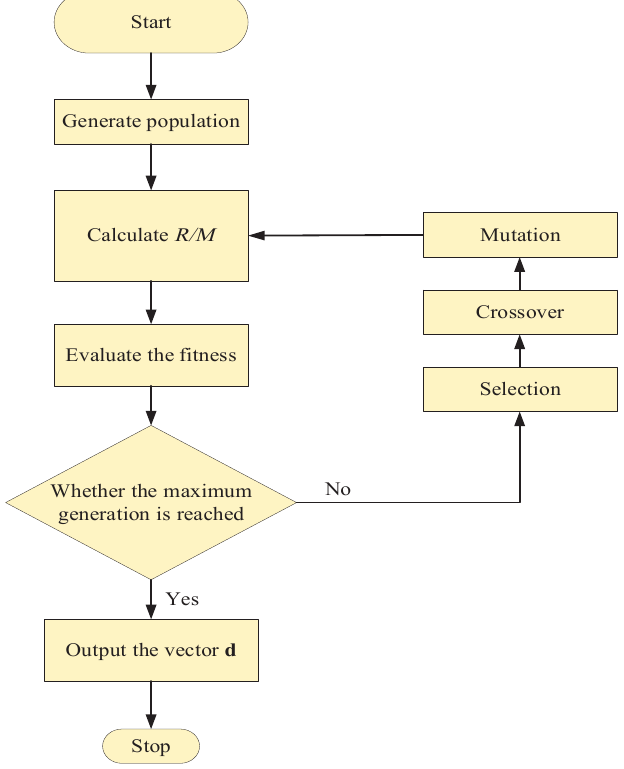
Figure 6. Optimization procedure of the distance between adjacent